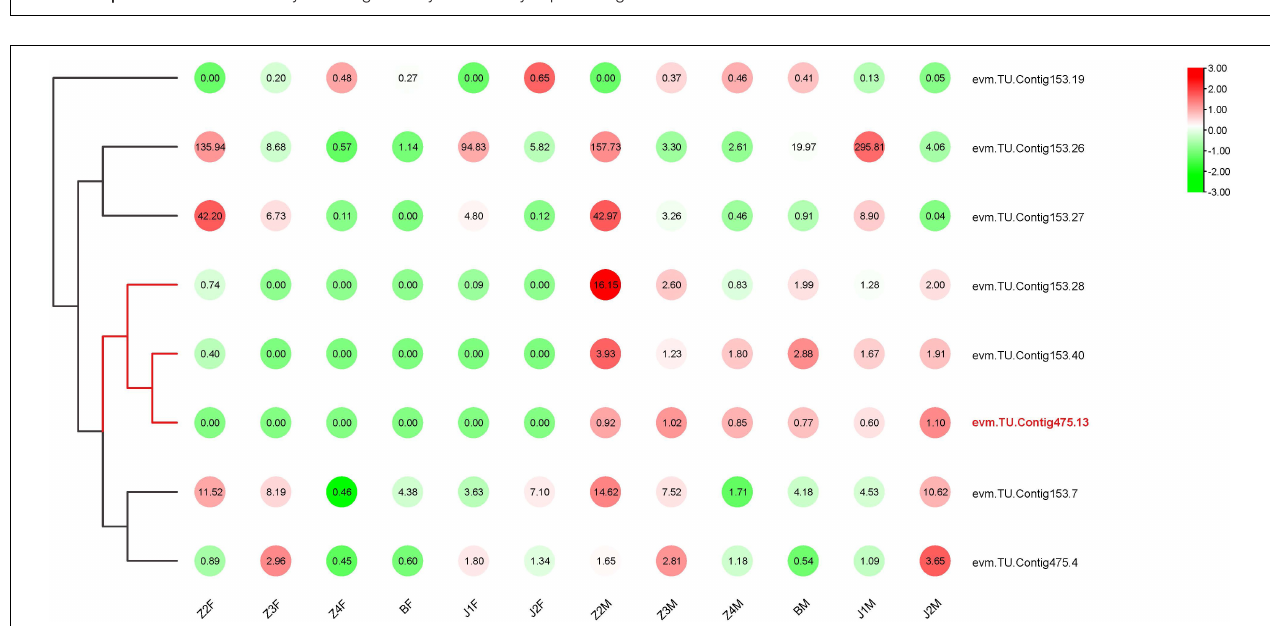
FIGURE 4 | KEGG enrichment analyses of significantly differentially expressed genes.